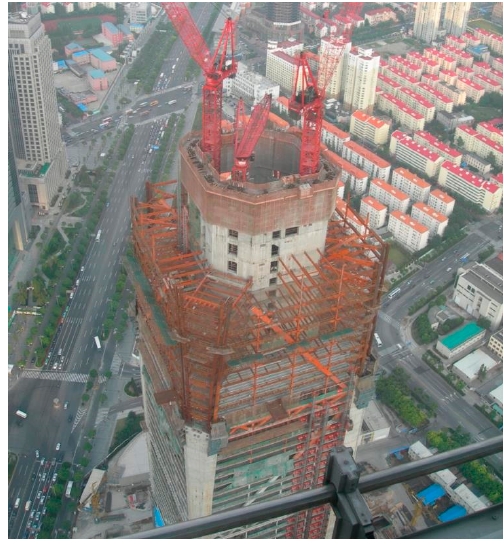
Figure 11. Shanghai World Financial Center during construction (Source: Wikipedia).